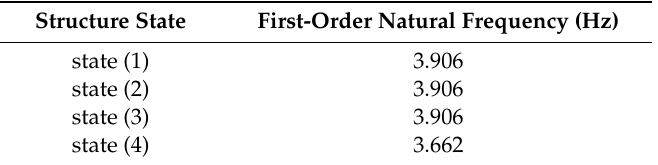
Table 2. Natural frequency of steel frame structure based on accelerometer.